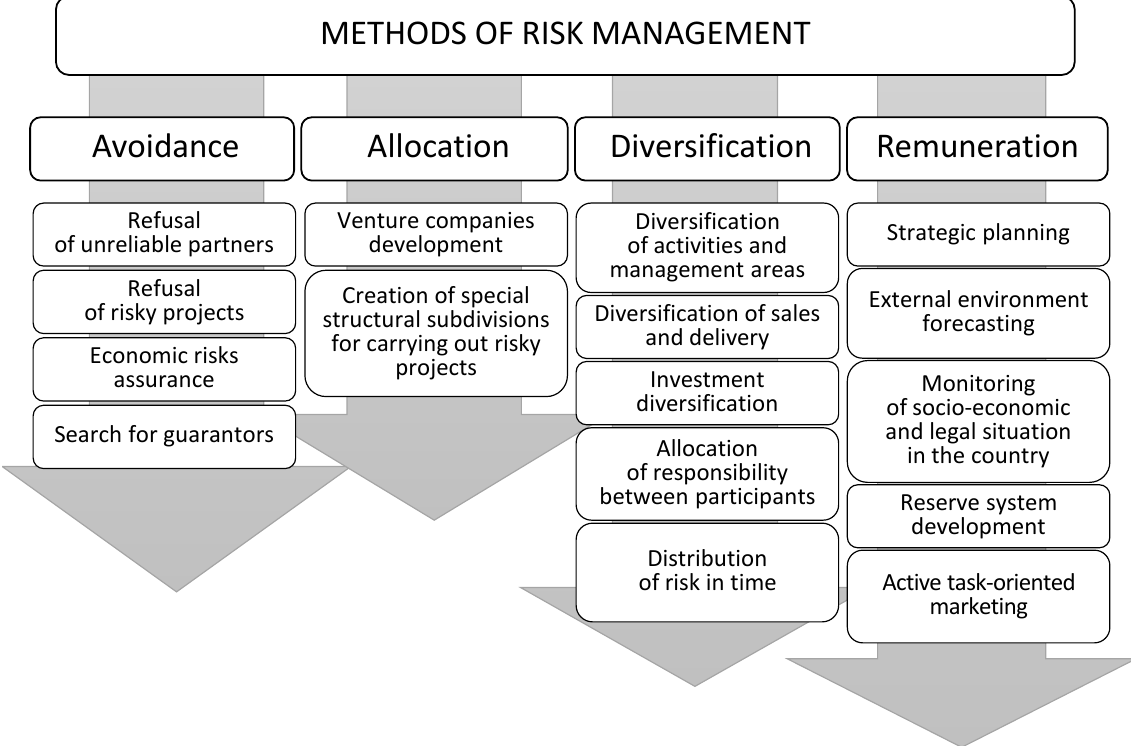
Figure 3. Methods of risk control for investment project